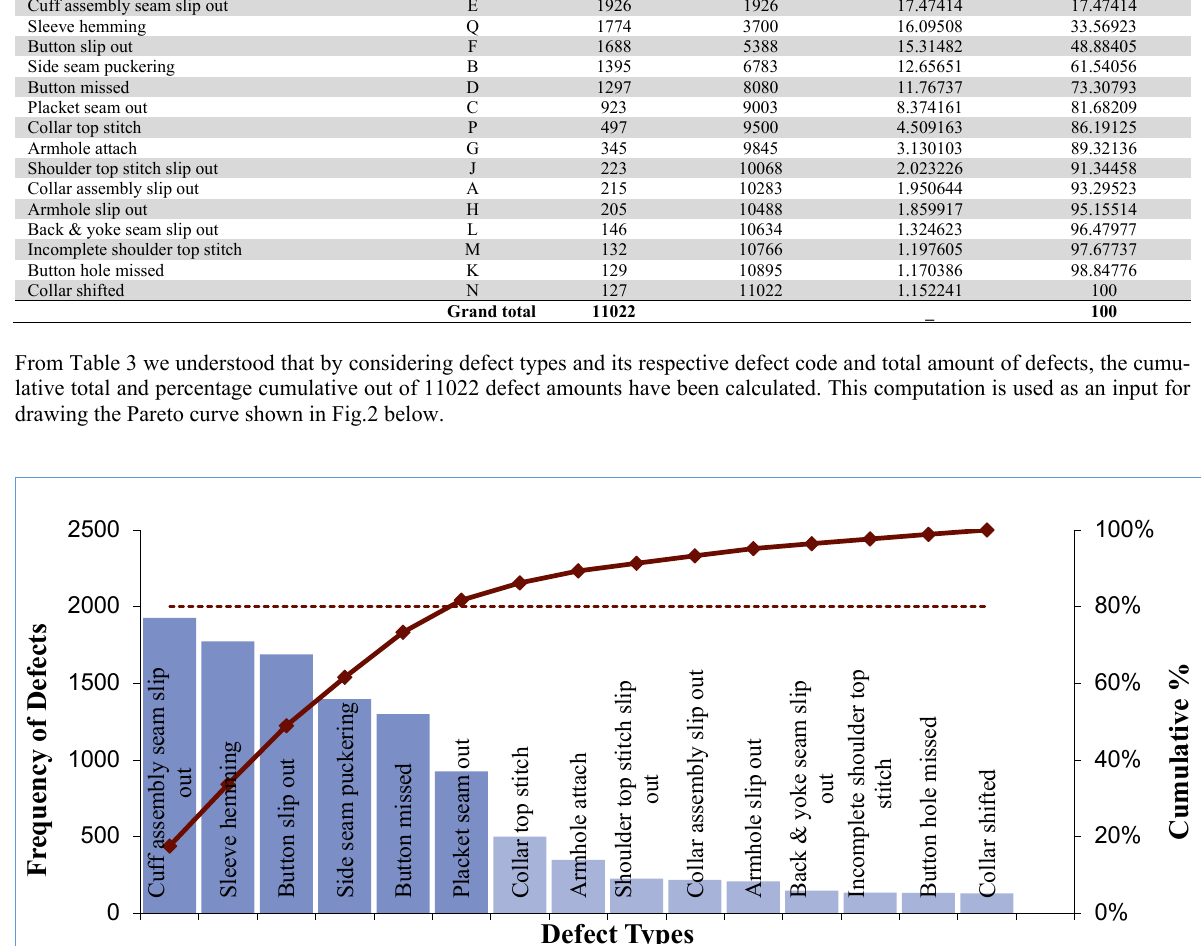
Defect type, respective defect amount and cumulative distribution 5 Defect type